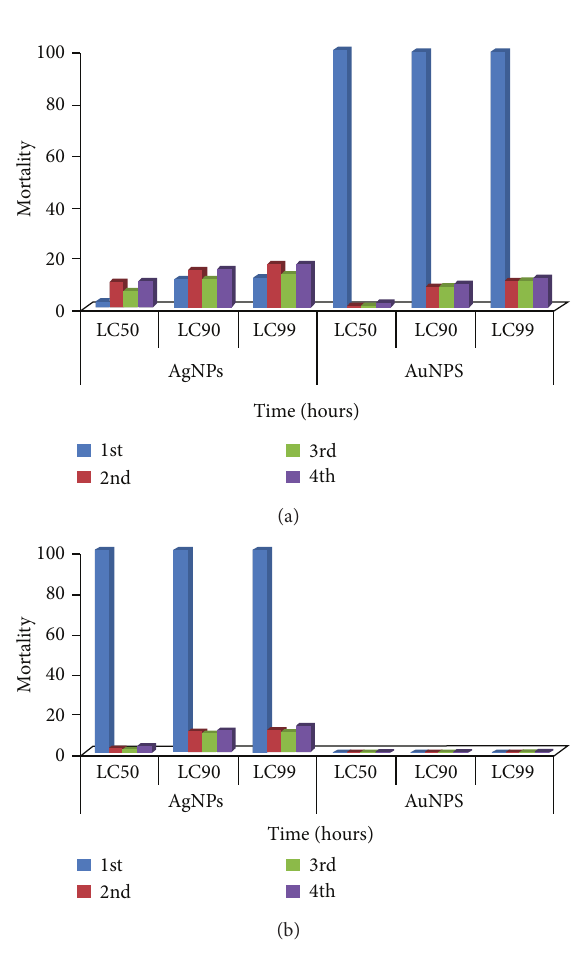
Figure 3: Efficacy of silver and gold nanoparticles against the larvae of Anopheles stephensi at different hours of exposure.